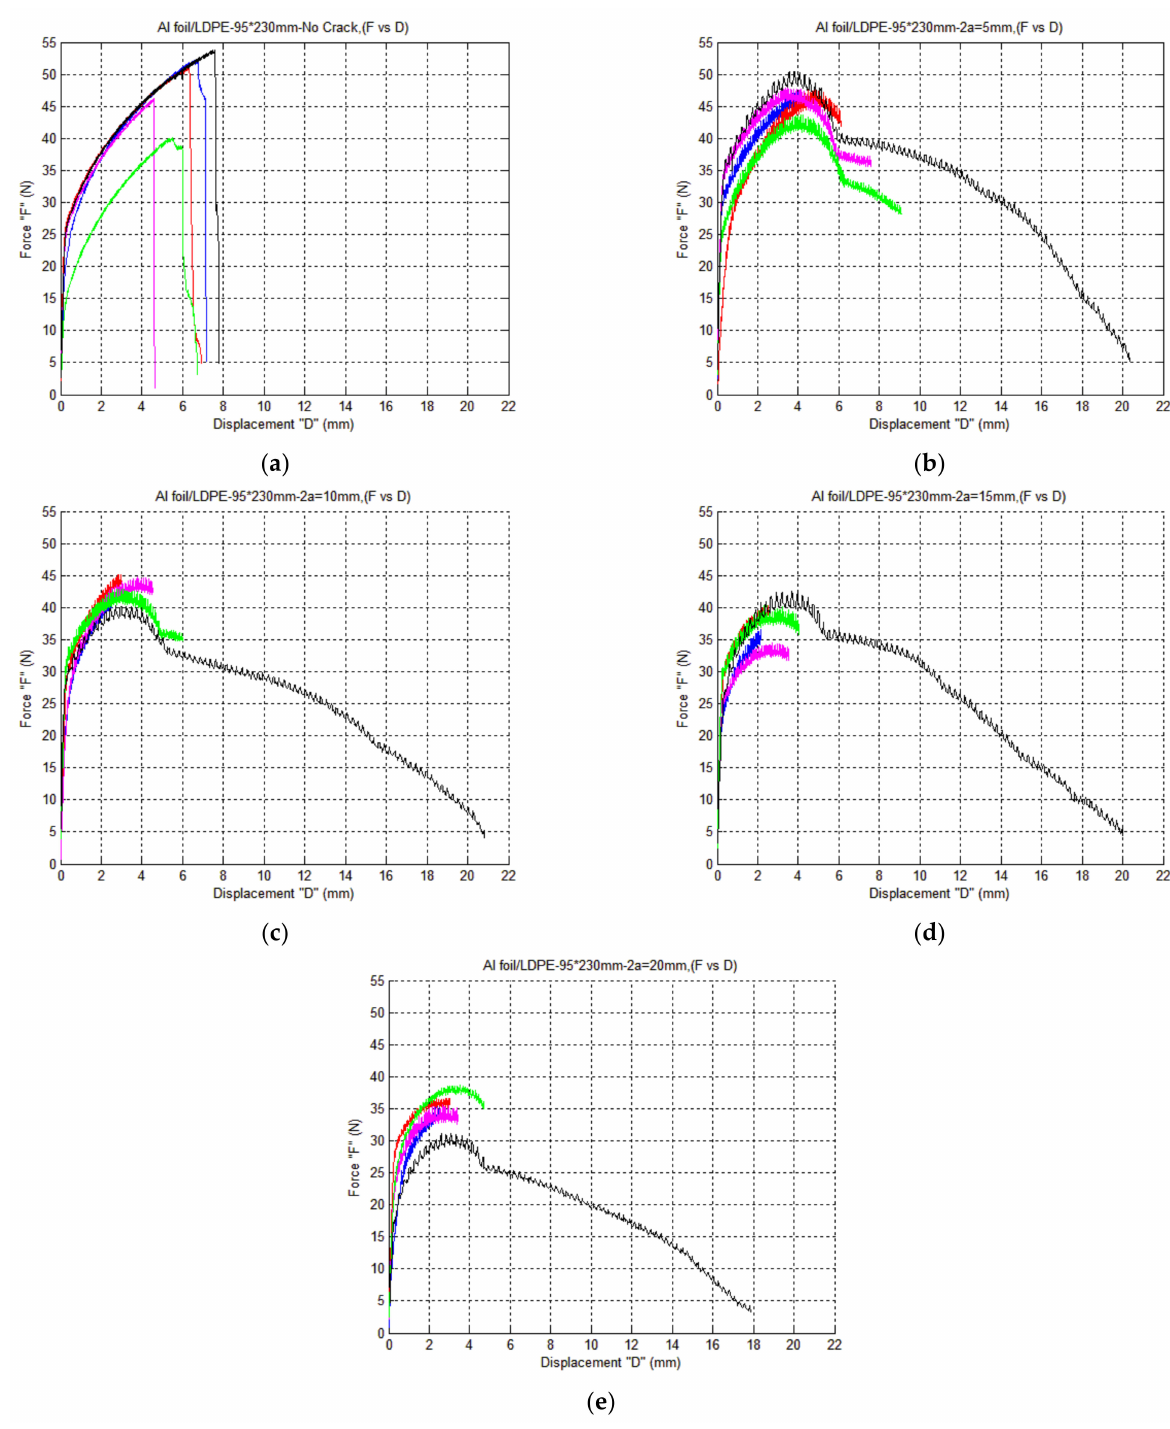
Figure A2. Experimental results for aluminum foil/LDPE. ( a ) F vs. D for 0 mm crack, ( b ) F vs. D for 5 mm crack, ( c ) F vs. D for 10 mm crack, ( d ) F vs. D for 15 mm crack, ( e ) F vs. D for 20 mm